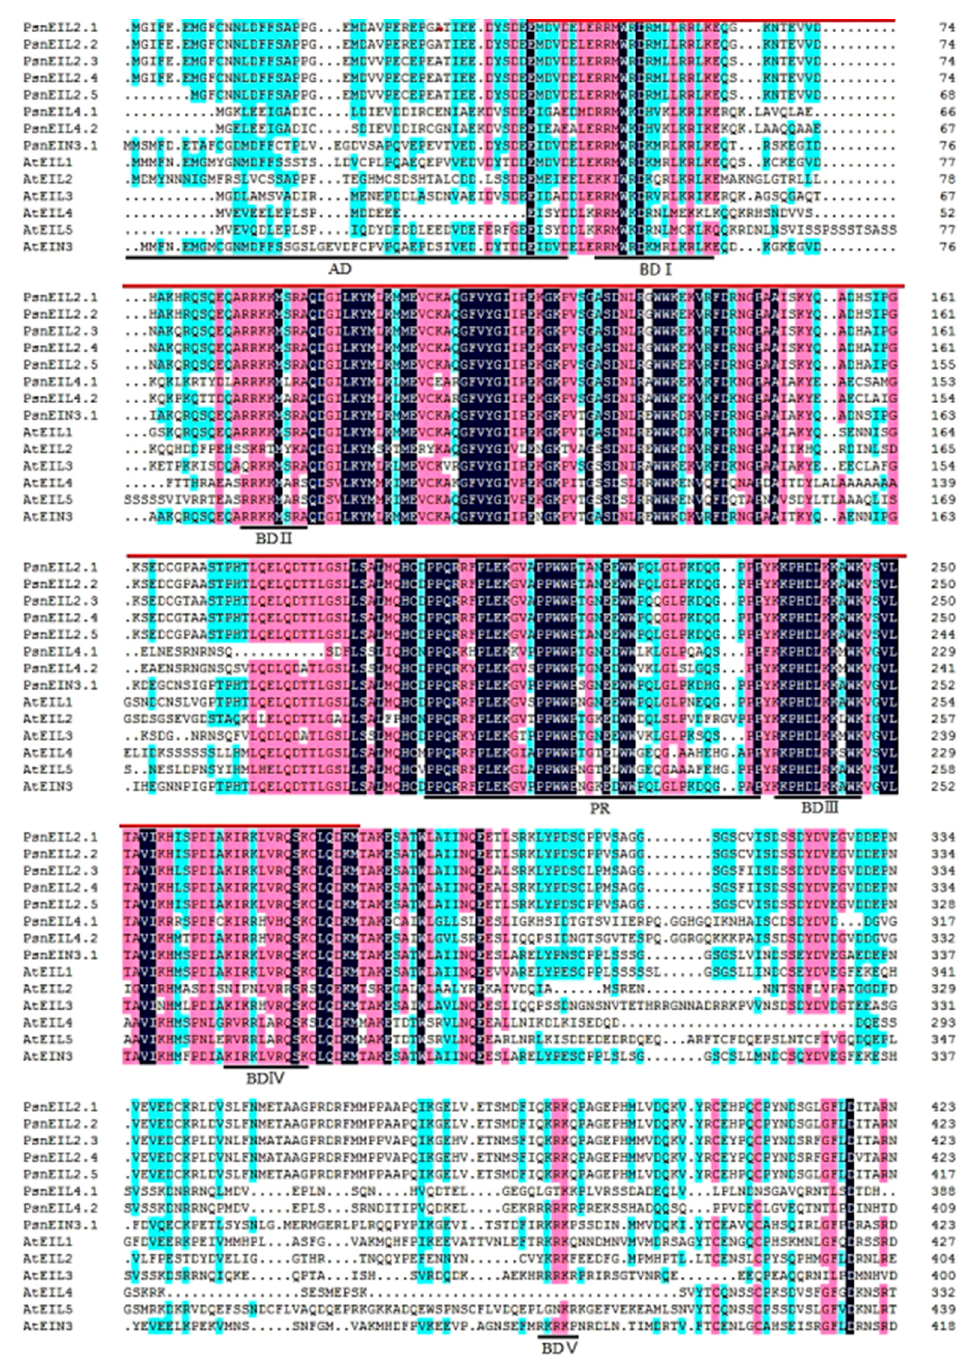
Figure 2. Sequence alignment of all identified EIN3/EIL genes in Populus × xiaohei and A. thaliana . Sequence comparisons were made via alignment using ClustaW, and identical or similar residues are shaded in different background colors. The areas with 100% similarity are displayed in black, pink indicates similarity of 75%, and blue indicates similarity of 50%. The approximate position of the EIN3 structural domain is shown as a red line above the matched sequences. Amino acid enrichment regions are indicated by black lines below the matched sequences: AD: acidic amino acid enrichment region; BDI–V: basic amino acid enrichment regionI–V; PR: proline enrichment